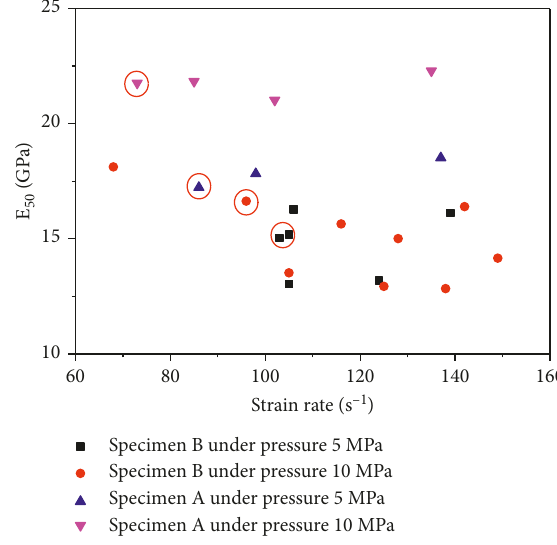
Figure 6: Variation in dynamic strength with strain rate.